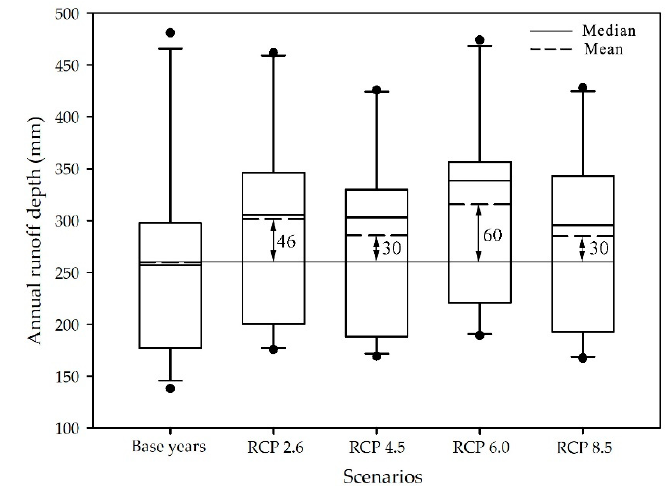
Figure 6. Annual runoff depth changes for the 2050s under RCP 2.6, RCP 4.5, RCP 6.0 and RCP 8.5 emission scenarios compared with the base years (2006–2016).